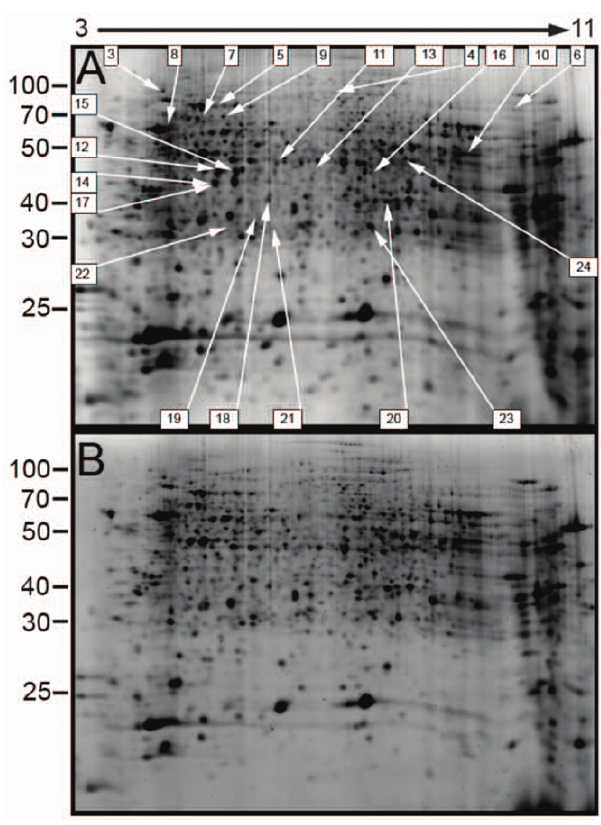
Figure 1. Representative 2D SDS-PAGE protein spot maps of larval midgut proteomes from larvae treated with buffer (A) or an LC 50 dose of Cry11Aa (B). Spots selected for identification by nano LC/MS/MS are indicated and numbered as in Table 1. Spot 18 corresponds to spots 18A and 18B. The gel pH gradient is denoted above the figure. Estimated protein molecular weights are shown at the left of the figure in kilodaltons.